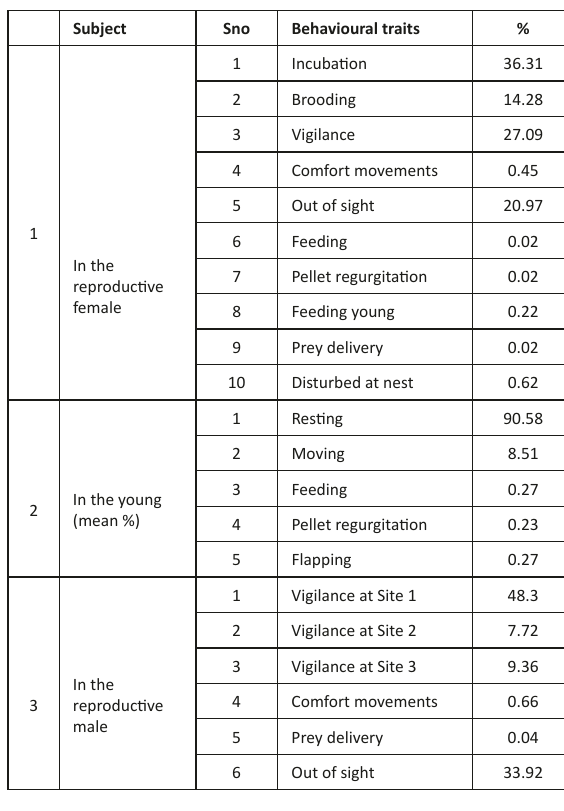
Table 1. Overall activity patterns and percentage of time spent on each behavioural